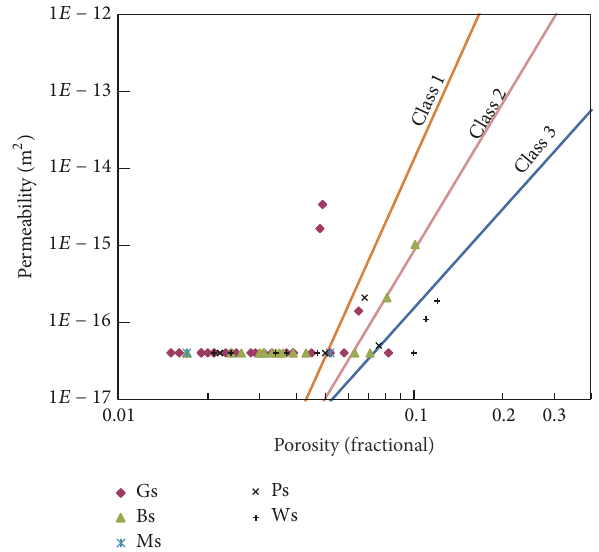
Figure 10: Crossplots of porosity and permeability for different types of dolomite rocks. Note the three lines which show the three classes of porosity-permeability relationship according to Lucia (1995). The permeability of the detection limit is 4 × 10 −17 m 2 .